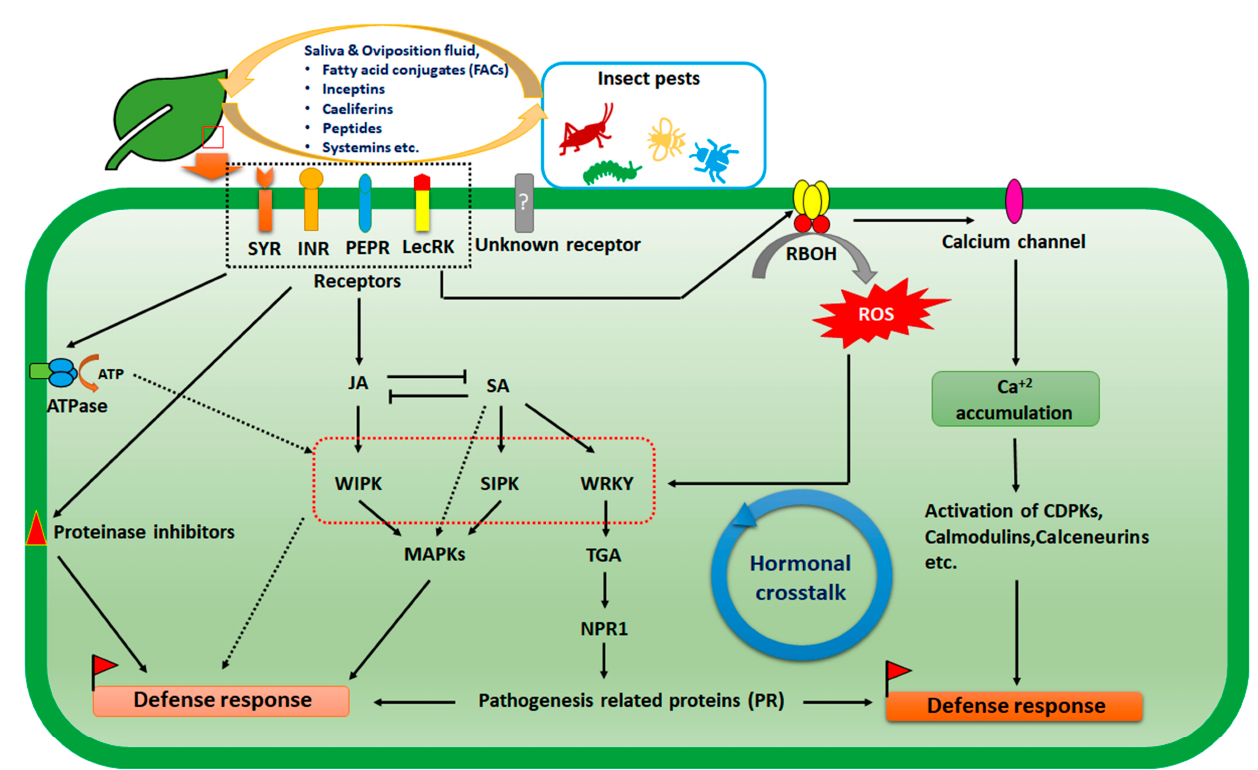
Figure 1. Schematic diagram highlighting molecular mechanism of plant–insect interaction.